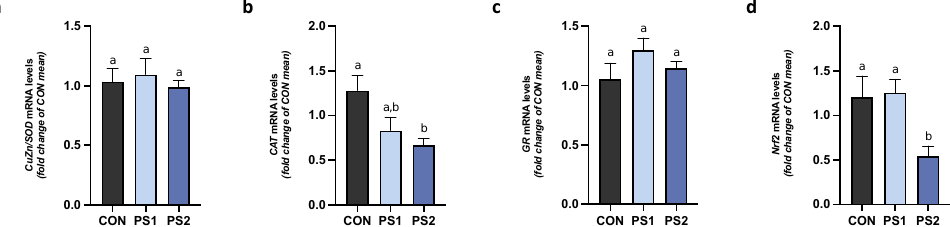
Figure 5. The alteration of antioxidant activity induced by PS-MPs in the posterior intestine (PI) of gilthead seabream. mRNA levels of ( a ) CuZn/SOD, ( b ) CAT, ( c ) GR, and ( d ) Nrf2 were measured after PS-MPs exposure in PI of gilthead seabream. All data are shown as mean ± S.E.M. Different letters indicate significant differences among treatments (at least p < 0.05).